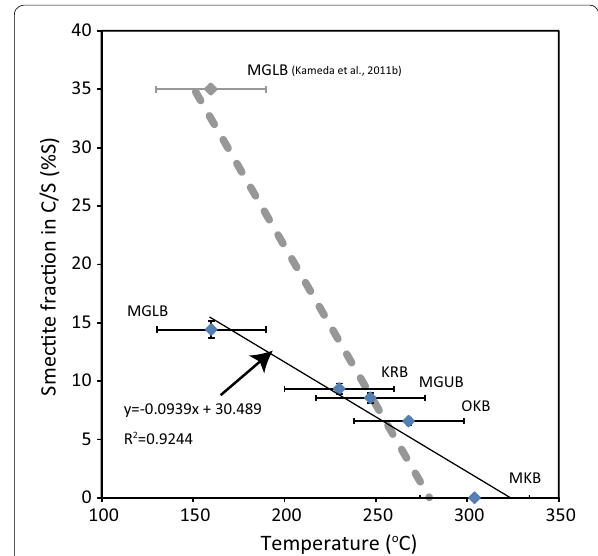
Fig. 7 Variations in %S values as a function of temperature with hori- zontal and vertical error bars of 30 °C (Laughland and Underwood ± 1993) and 5% (Hillier 1993), respectively. The diagram also shows ± variations in saponite content within sample MGLB as determined by Kameda et al. (2011a). The conversion reaction rate reported by Kameda et al. (2011c) is shown as a dotted gray